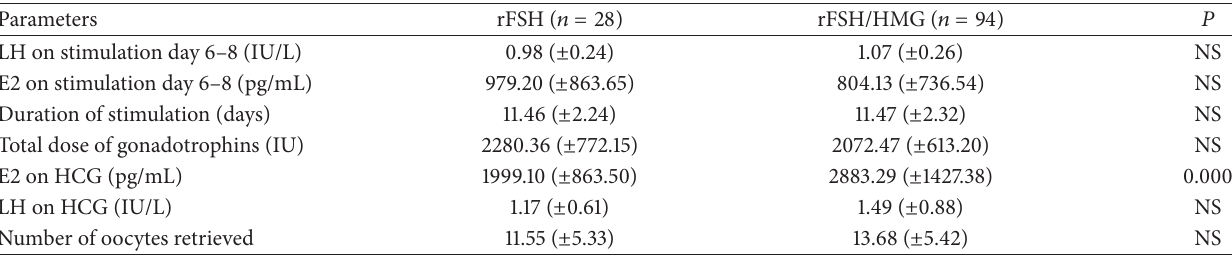
Table 2: The stimulation and response details.